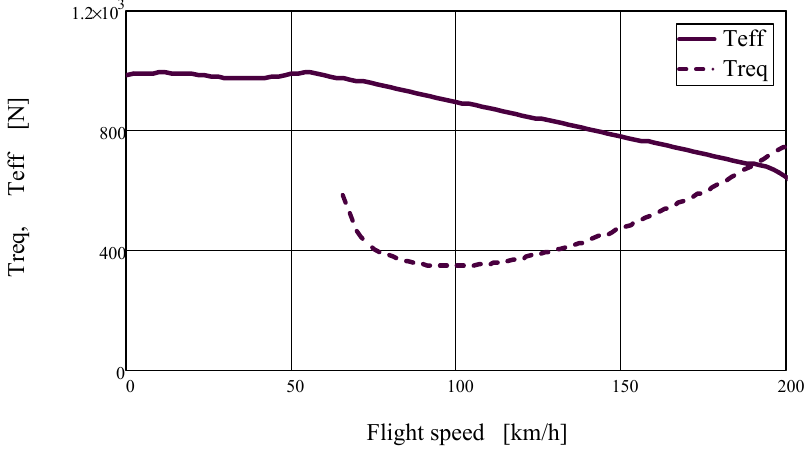
Figure A5. Curves of available and required thrust for a small sport aircraft m = 473 kg at a cruise configuration with three-blade propeller: D = 1.75 m, φ 0,75 = 22°, maximum cruise-regime power 47.9 kW.